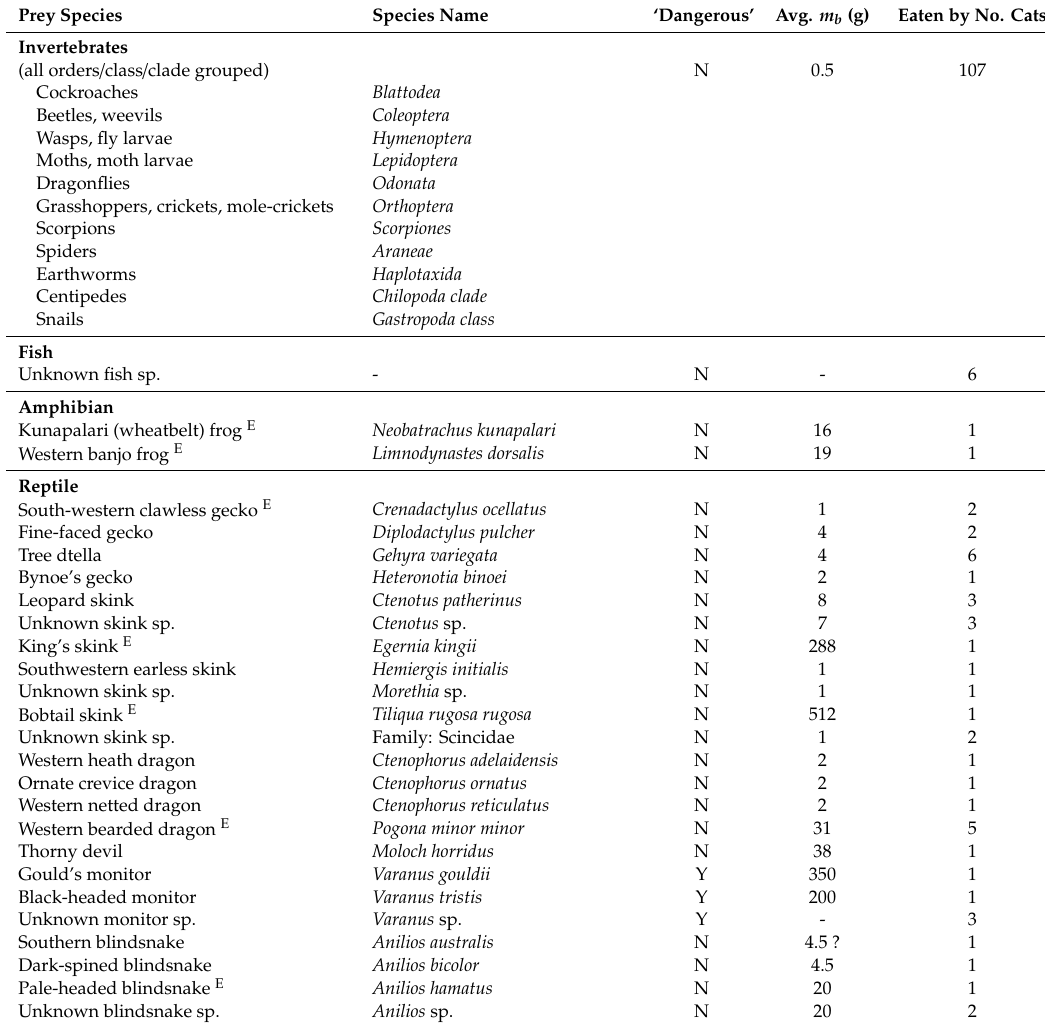
Table 4. List of prey species identified from stomach content analysis of n = 294 feral and stray cats ( Felis catus ) from southwest Western Australia that had fauna present in their stomachs. The number of cats eating each prey item does not equal the total number of species eaten as many cats ate > 1 species. Except for invertebrates (which were all assigned an arbitrary mass value of 0.5 g, regardless of whether or not we could identify them), analysis of prey mass excluded prey items that could not be identified su ffi ciently to ascribe a mass to the item. The average body mass for each prey species (carried out for n = 611 prey items) represents an approximation of adult size from various sources in the literature. Prey were distinguished as potentially ‘dangerous’ prey species—a subjective category based on the authors’ experience of those species that could potentially deliver a reasonable bite or kick while being